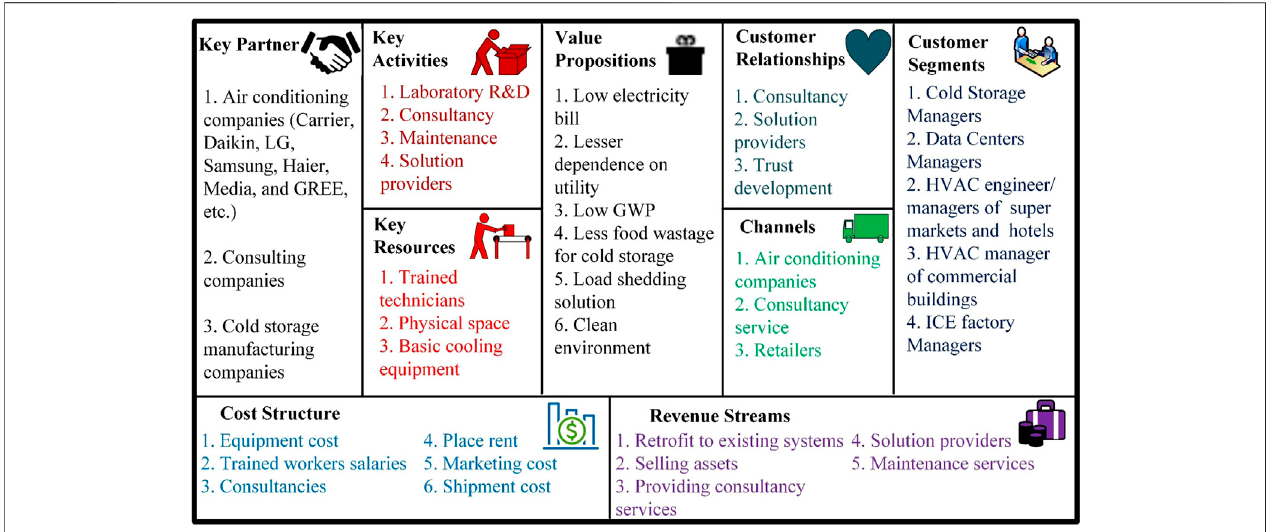
FIGURE 11 | First BMC describing the feasibility, desirability, and viability of solar thermal cooling adapted from Osterwalder and Pigneur (2010), Van Der Pijl et al. (2016a), Strategyzer AG. (2018).